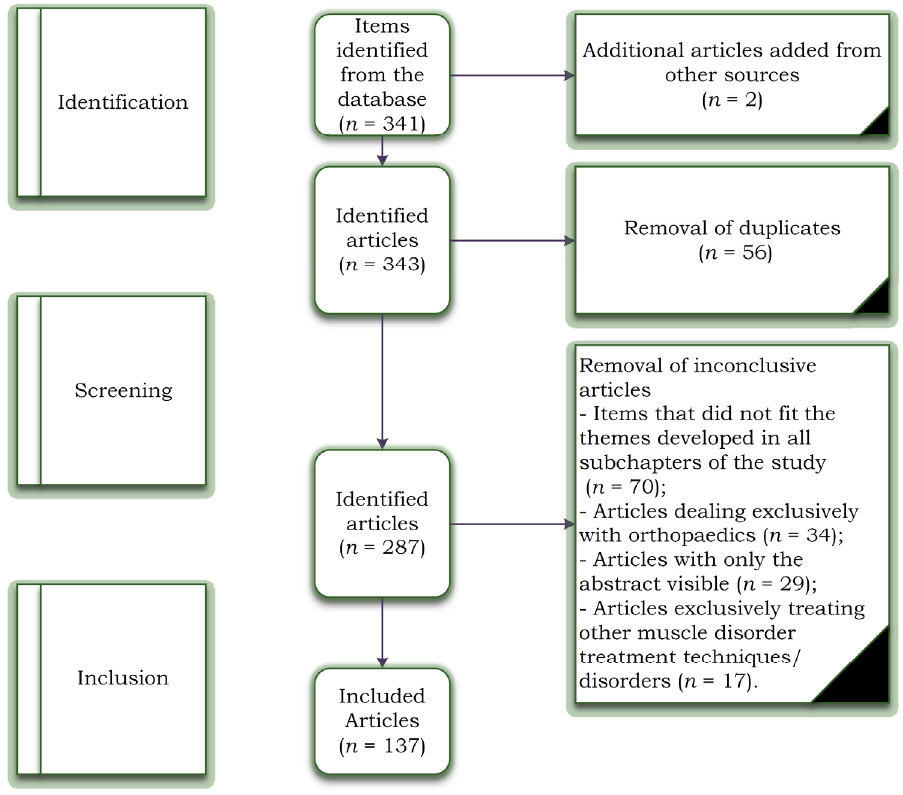
Figure 1. Study selection flowchart based on PRISMA criteria.